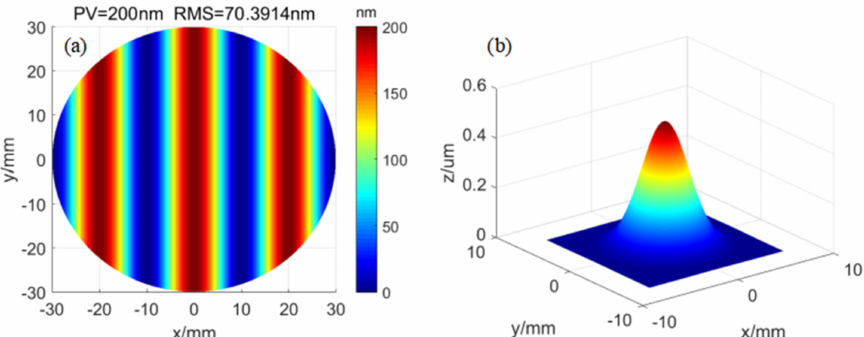
Figure 10. Parameters of the simulation: surface figure error ( a ), and the removal function ( b ). In the simulation, the dwell time was solved using the generalized minimum residual (GMRES) method with 100% surface figure error removal amount and compensation of the removal function according to the curvature of the surface. Then, the convolution of the curvature compensated for removal function with the dwell time, the convolution of removal function with 10 (cid:48) angle error with the dwell time, and the convolution of removal function with 1 ◦ angle error with the dwell time were calculated and subtracted from the initial surface figure error, respectively. The simulated residual errors of these three cases are shown in Figure 11a–c, respectively. The RMS values of the residual error of Figure 11a–c were 0.0016 nm, 2.3514 nm, and 0.3893 nm, respectively. Therefore, the angle error cannot be ignored in figuring curved surfaces for achieving sub-nanometer accuracy.